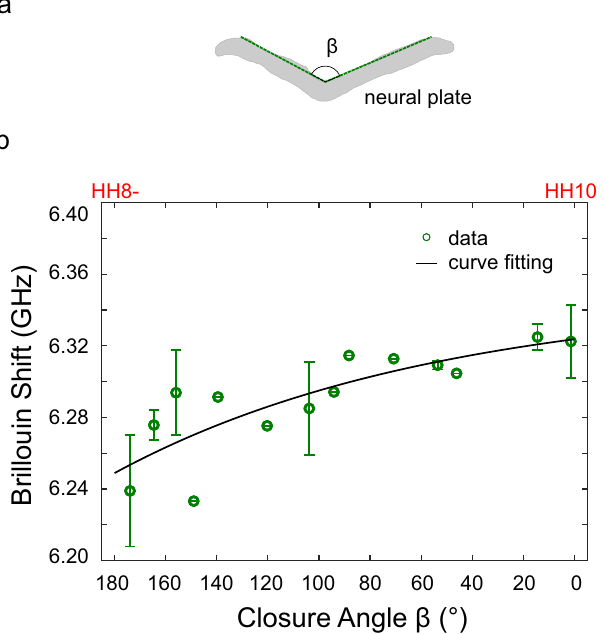
Figure 4. Increase in Brillouin Shift is correlated with tissue bending for ex ovo cultured embryos. ( a ) Definition of the closure angle. ( b ) Closure angle is correlated with average Brillouin shift of neural plate. Data from embryos in developmental stages of HH 8- to HH 10 are collected. β = 180 ◦ and 0° represents the neural plate is flat and fully closed, respectively. Embryos are distributed into each 10° interval based on the closure angle. Data point represents the average value of the embryos within the same interval. Error bar represents the standard deviation. Solid curve is fitting result of an empirical